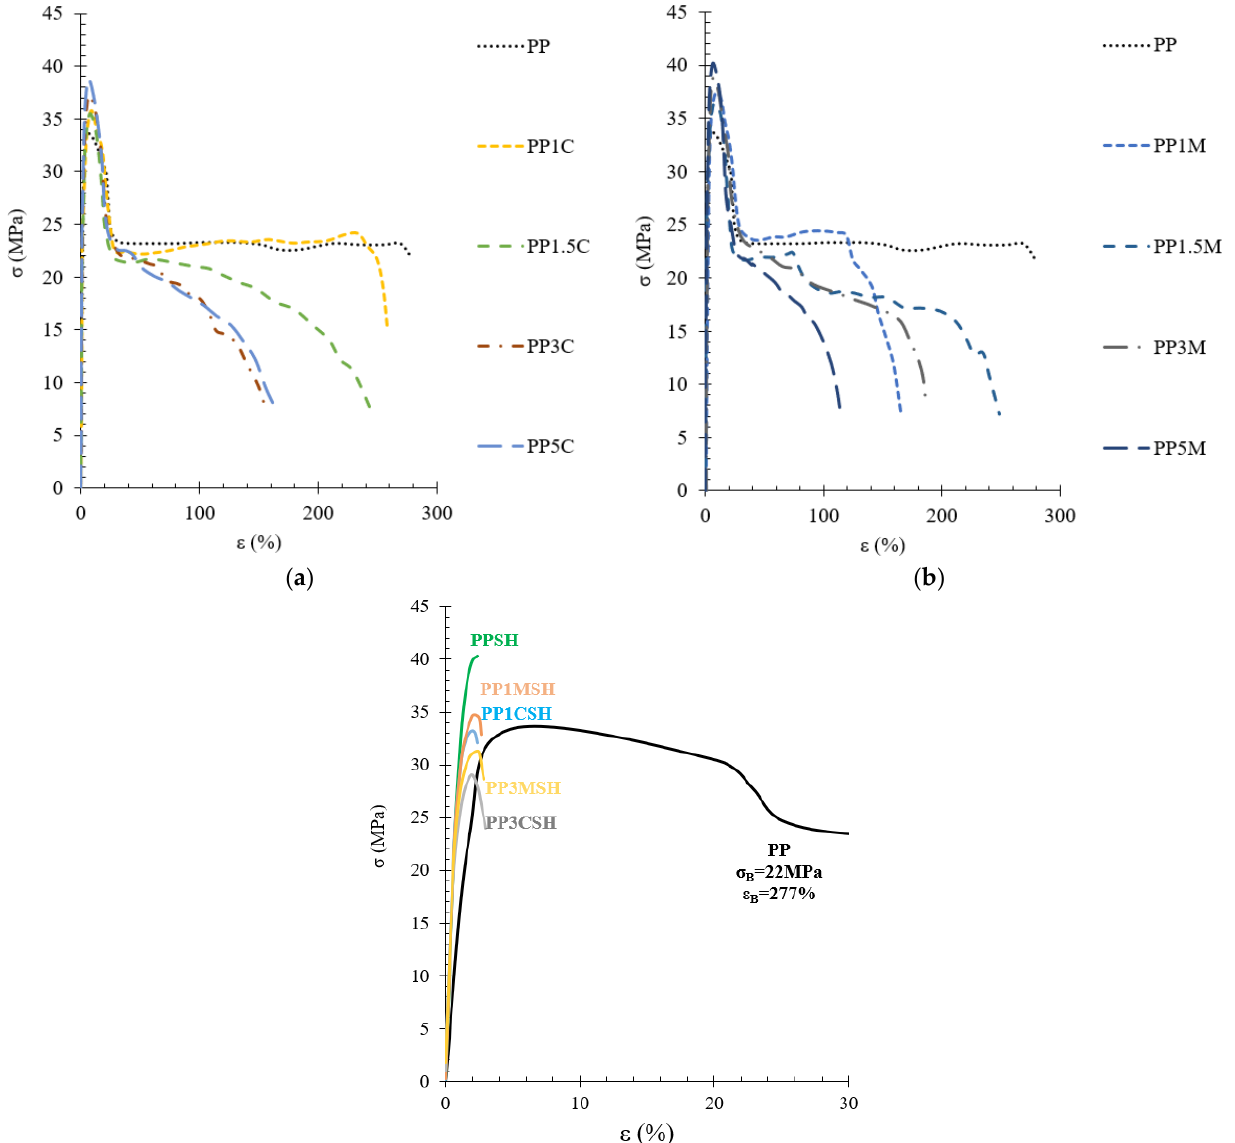
Figure 8. Tensile stress – strain diagrams of PP nanocomposites with C ( a ), M ( b ), and PP hybrid composites with SH and nanoclay ( c ).